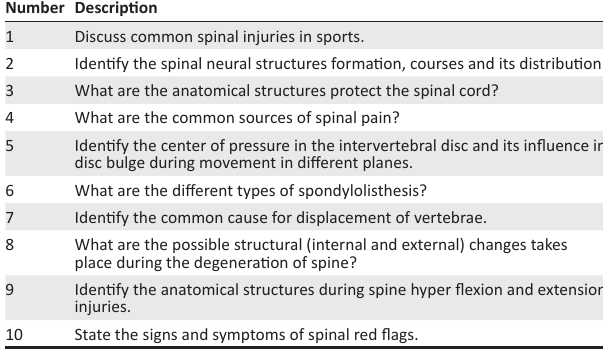
TABLE 3: The learning objectives in task 2 were focused on understanding the common pathologies of spine in both traditional and Augmented Reality teaching methods.